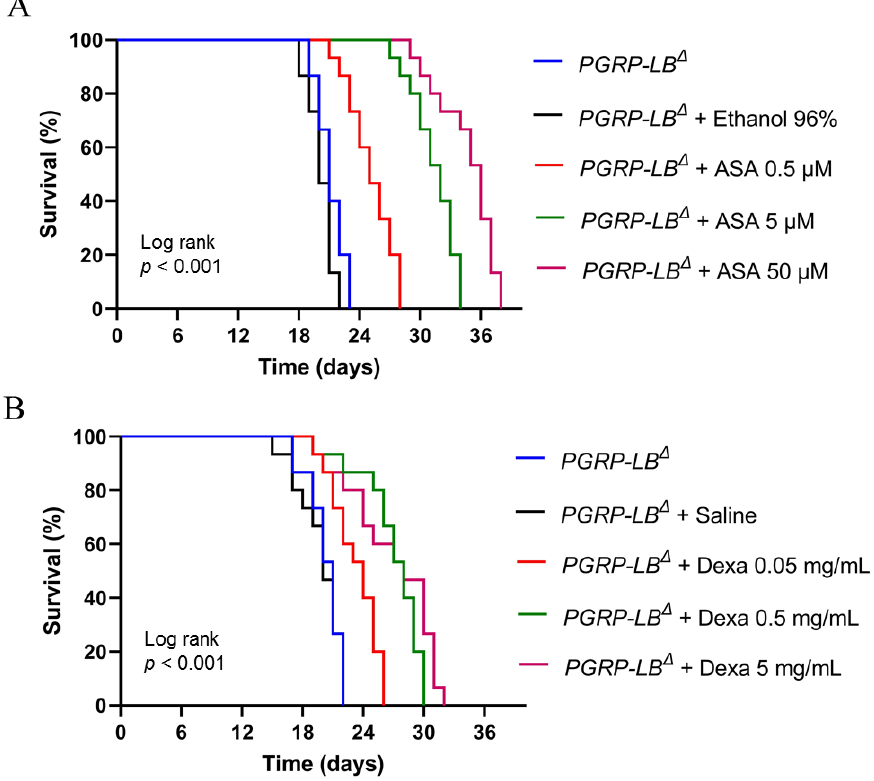
Figure 5. Survivorship of adult males of PGRP-LB ∆ in the presence or absence of aspirin ( A ) or dexamethasone ( B ). For each survival experiment, adult males of PGRP-LB ∆ at 2–4 days old were maintained at 25 °C in fly food containing the respective drug/active compounds. The numbers of surviving and dead flies were recorded daily, and fly survivorship was analyzed using a Kaplan – Meier Log Rank approach. ASA, Aspirin; Dexa, Dexamethasone.